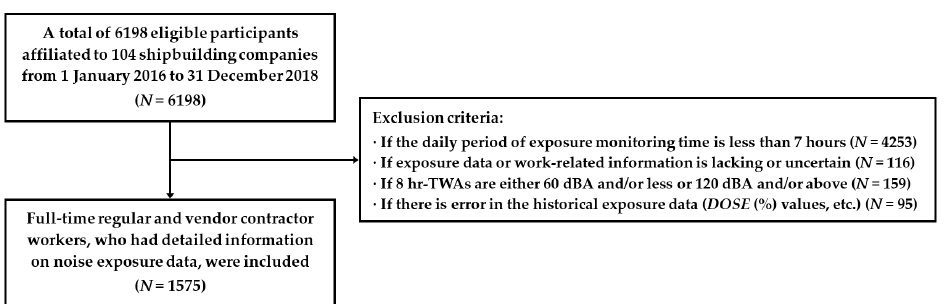
Figure 1. Flow diagram for selection of study subjects.